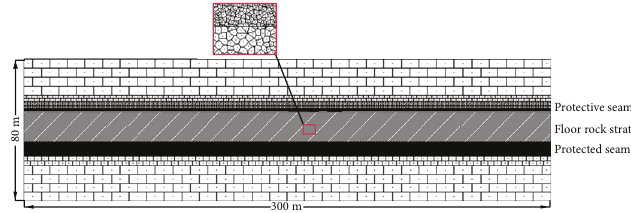
Figure 5: Schematic diagram of the numerical